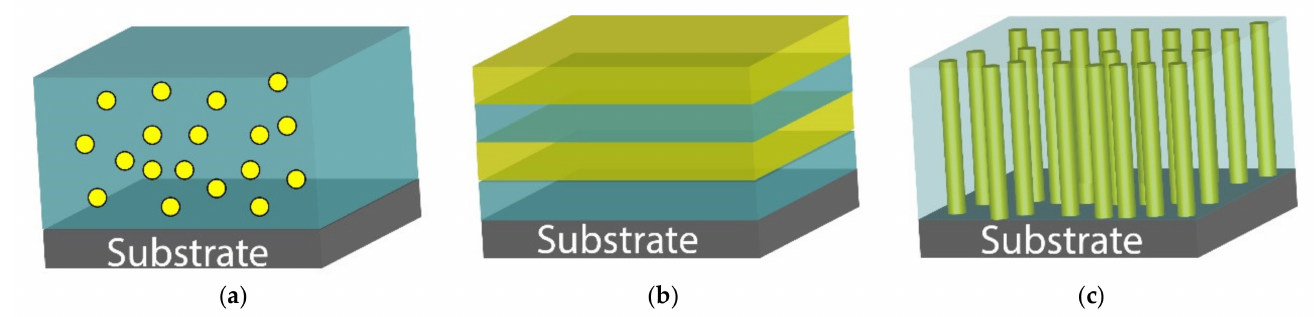
Figure 1. Schematic of ( a ) 0–3, ( b ) 2–2, and ( c ) 1–3 type magnetoelectric composite